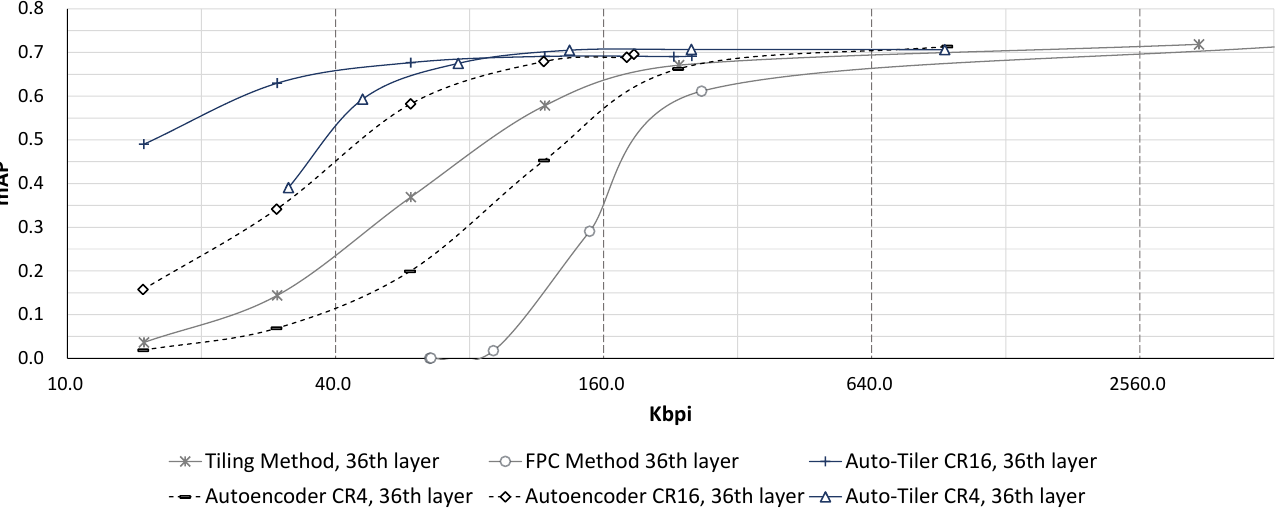
Figure 11. mAP comparison of an auto-tiler, autoencoder, and existing methods at 36th layer.